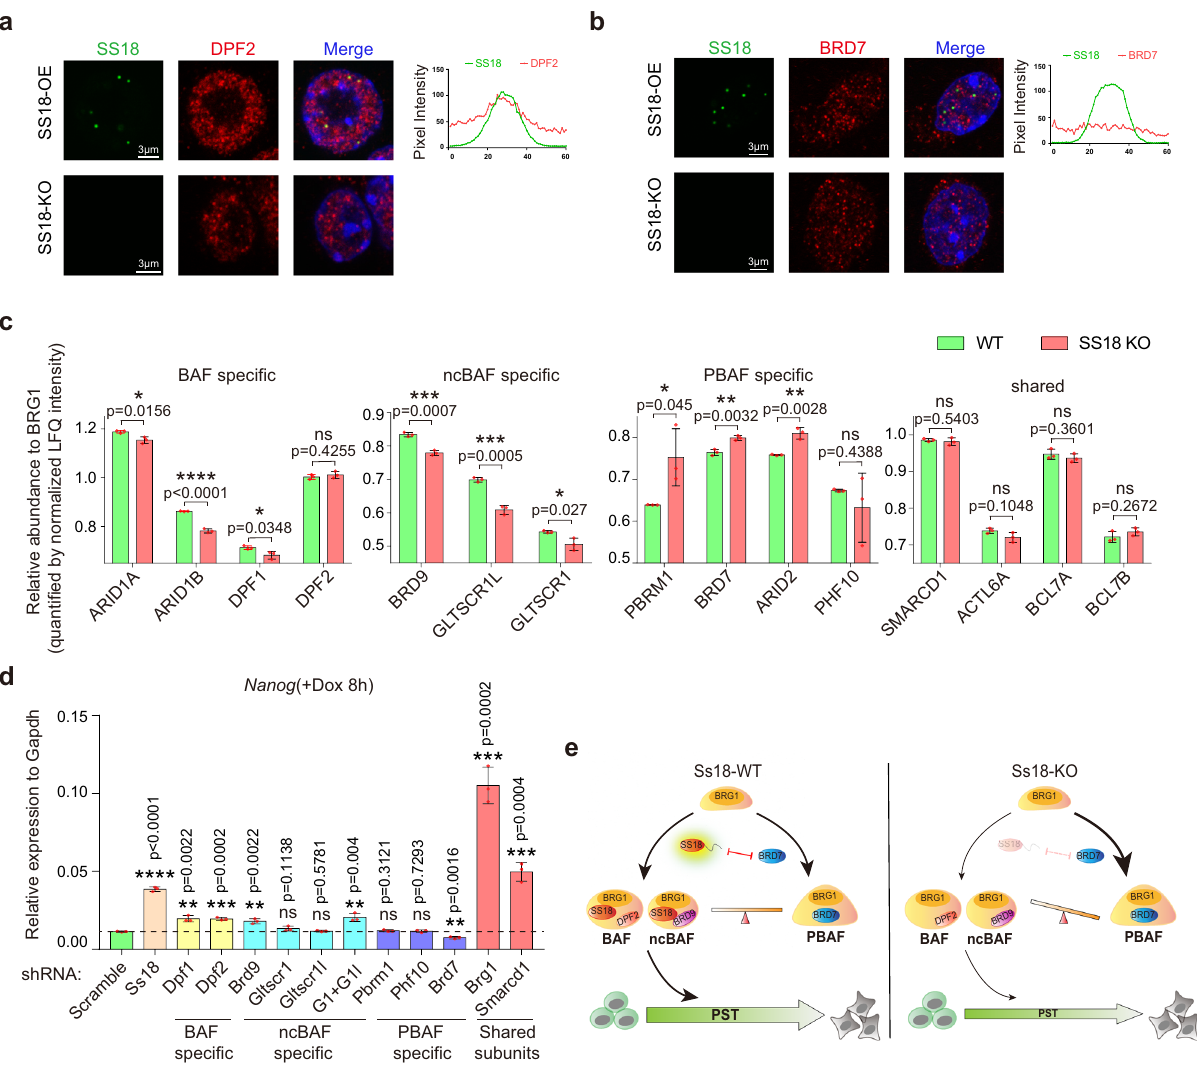
Fig. 6 SS18 regulates PST through mediating the assembly balance among BAF ncBAF and PBAF. a Representative images of immuno fl uorescence for endogenous BAF speci fi c subunit DPF2 in SS18KO mESCs infected with lentiviral SS18-EGFP. The graph on the right shows pixel intensity across fi ve condensates of SS18-EGFP (green) and DPF2 (red). Scale bars, 3 μ m. SS18-EGFP, laser intensity 2.5%, detector gain 500 V. DPF2 immuno fl uorescence, laser intensity 3.5%, detector gain 750 V. Both SS18-EGFP and DPF2 immuno fl uorescence were processed by background subtraction. Three independent experiments. b Representative images of the immuno fl uorescence for endogenous PBAF speci fi c subunit BRD7 in SS18KO mESCs with exogenous SS18- EGFP. The graph on the right shows pixel intensity across fi ve condensates of SS18-EGFP and BRD7 (red). Note no co-localization between SS18 and BRD7. Scale bars, 3 μ m. SS18-EGFP, laser intensity 2.5%, detector gain 500 V. BRD7 immuno fl uorescence, laser intensity 3.5%, detector gain 750 V. Both SS18- EGFP and BRD7 immuno fl uorescence were processed by background subtraction. Three independent experiments. c The histogram shows the relative precipitated abundance of indicated proteins to BRG1 as quanti fi ed by normalized LFQ intensity from IP-MS experiments by anti-BRG1 antibody performed on WT and SS18KO mESCs. IP-MS experiments were performed in triplicates and a two-sample t test was applied. Data are mean ± s.d., two-sided, unpaired t test; n = 3 independent experiments, * p < 0.05, ** p < 0.01, *** p < 0.001, **** p < 0.0001. d The expression levels of Nanog by Jun-FlagTetON mESCs at 8 h during PST with knocking down of indicated components of BAF ncBAF or PBAF. G1 + G1l, knockdown Gltscr1 and Gltscr1l jointly. Data are mean ± s.d., two -sided, unpaired t test; n = 3 independent experiments, ** p < 0.01, *** p < 0.001, **** p < 0.0001. e A working model for SS18-mediated PST. SS18 functions by interacting with BAF or ncBAF subunits through its N-terminal 70aa, and forming condensates through a tyrosine-rich IDR. Meanwhile, the full length of SS18, co-localizing with BAF-speci fi c component and isolating PBAF-speci fi c one, can promote the BAF complex assembly and impair that of PBAF. In WT cells, BAF ncBAF and PBAF reach a balance. In SS18KO cells, the balance shifts towards PBAF to cause a delay in PST. Immuno fl uorescence . Cells growing on coverslips were washed three times with Immunoblotting . Cells were collected and lysed in lysis buffer supplemented with PBS, then fi xed with 4% PFA for 30min, and subsequently penetrated and blocked protease inhibitor cocktail (Roche) on ice for 15 min, and then cells were boiled in with 0.1% Triton X-100 and 3% BSA for 30 min at room temperature. Then, the 100 °C for 10min. After centrifugation, the cell supernatants were subjected to cells were incubated with primary antibody for half hour. After fi ve washes in PBS, SDS – PAGE and incubated with corresponding primary antibody and secondary 1 h of incubation in secondary antibodies, cells were then incubated in DAPI antibodies. The following antibodies were used in the project: anti-SS18 (CST no. (Sigma-Aldrich D9542) for 2min. Then, the coverslips were mounted on the slides 21792. 1:1000), anti-EGFP (CST no. 2555 s, 1:1000), anti-GAPDH (KangChen Bio- for observation on the confocal microscope (Zeiss LSM 900 with Airyscan detec- tech, no. KC-5G5, 1:1000), anti-JUN (abcam, no. ab31419, 1:1000), anti-BAF155 tor). The following antibodies were used in this project: anti-SS18, (CST no. 21792. (Santa Cruz Biotechnology, no. sc-32763, 1:500). NATURE COMMUNICATIONS| (2021) 12:4090